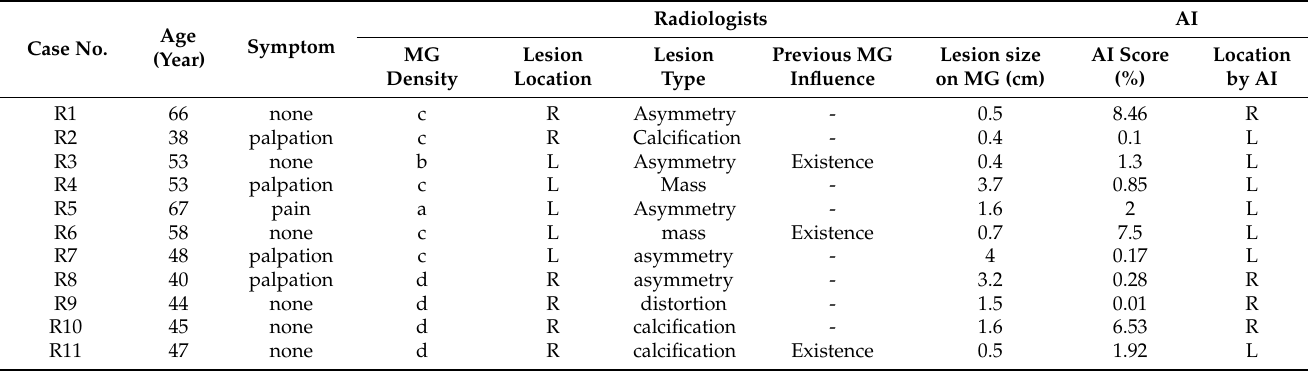
Table 6. Invisible cases in AI and concordant cases only in radiologists’